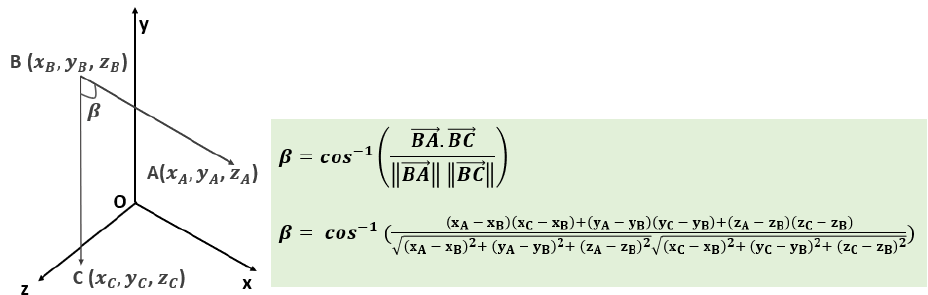
Figure 6. The example of calculating the angle between three points (A, B, C) in three